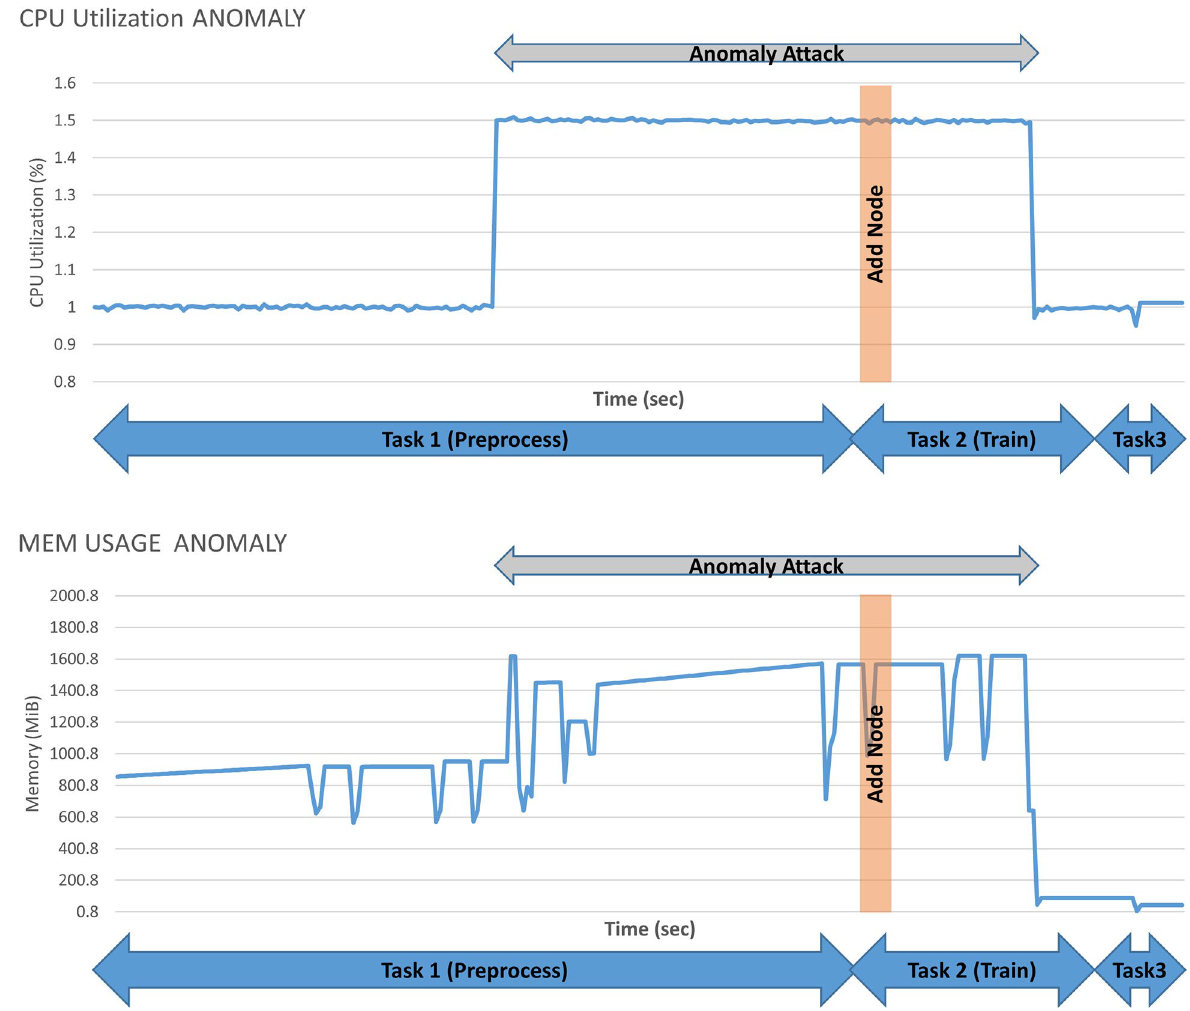
Fig. 10 CPU utilization and memory usage during an anomaly